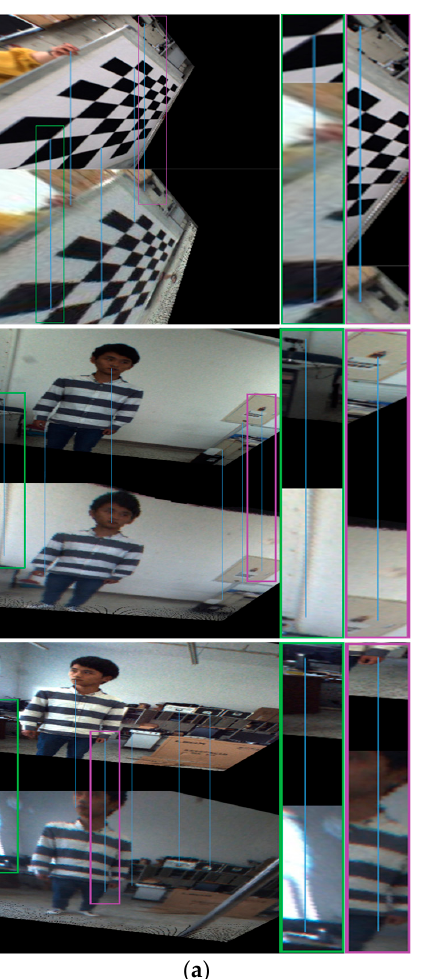
Figure 8. Three examples of the image pairs used for rectification accuracy comparison.